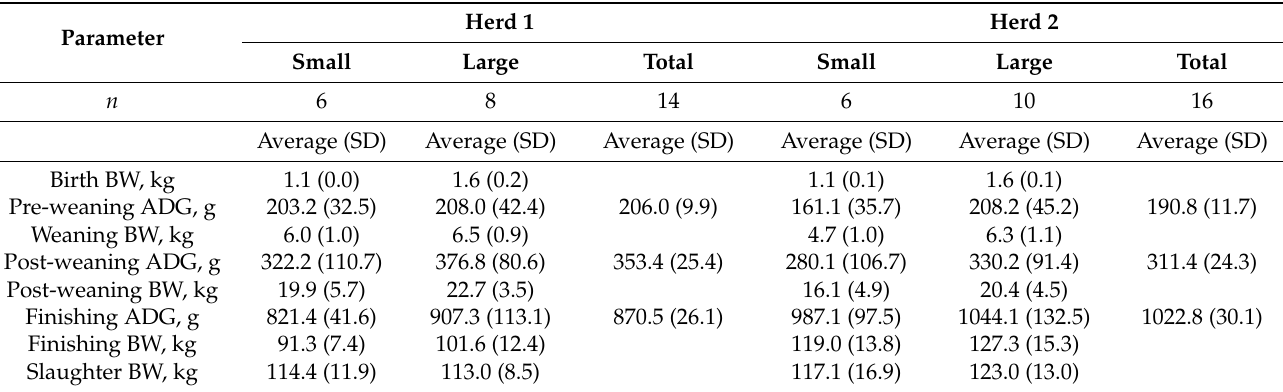
Table 2. Average bodyweight (BW), average daily weight gain (ADG), and their standard deviations (SD) of piglets born either small (S) or large (L) ( n = 30) at different time points.